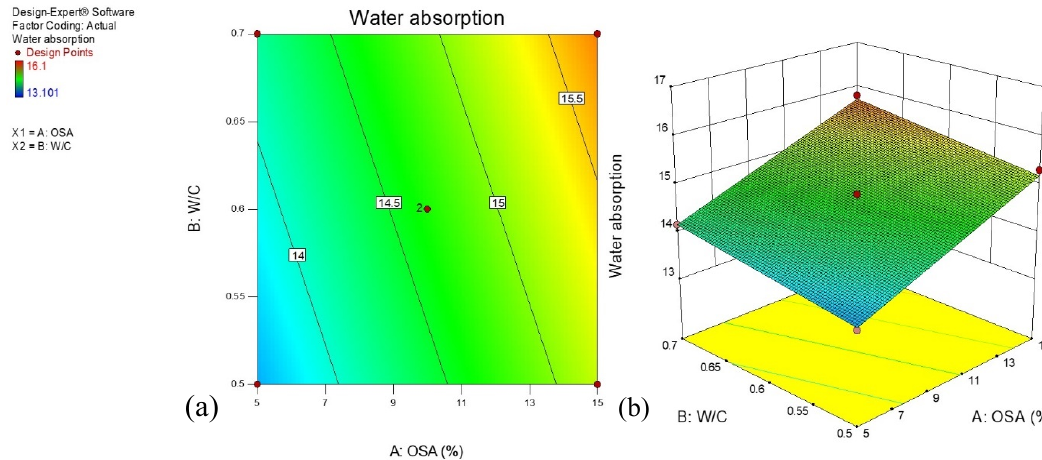
Figure 8. ( a ) 2-D and ( b ) 3-D plots for flexural strength of geopolymer